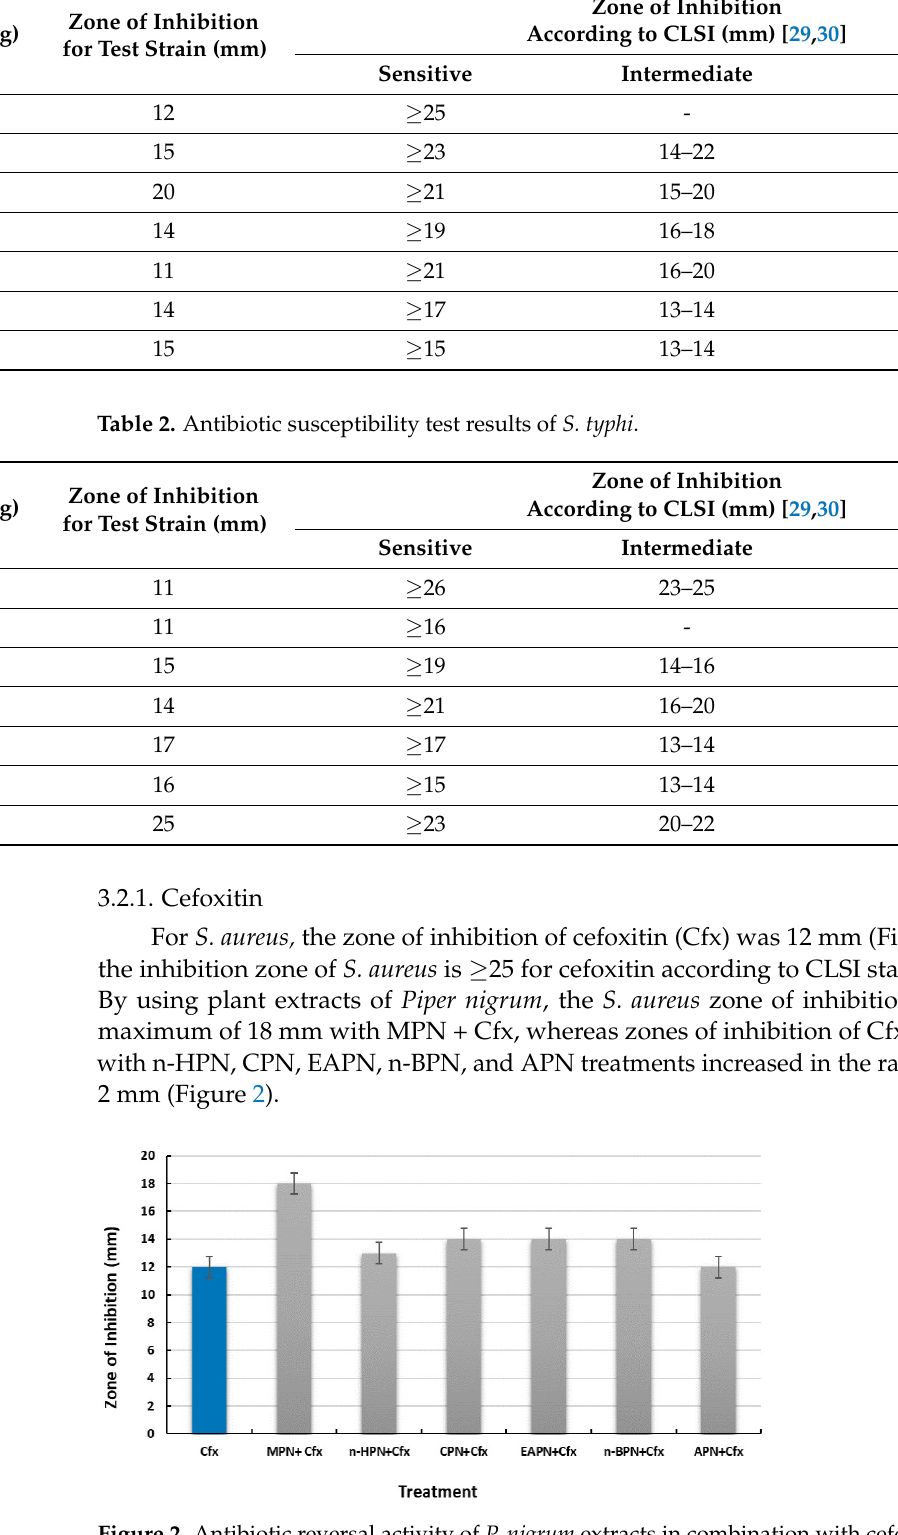
Figure 2. Antibiotic reversal activity of P. nigrum extracts in combination with cefoxitin (30 μg) for S. aureus.